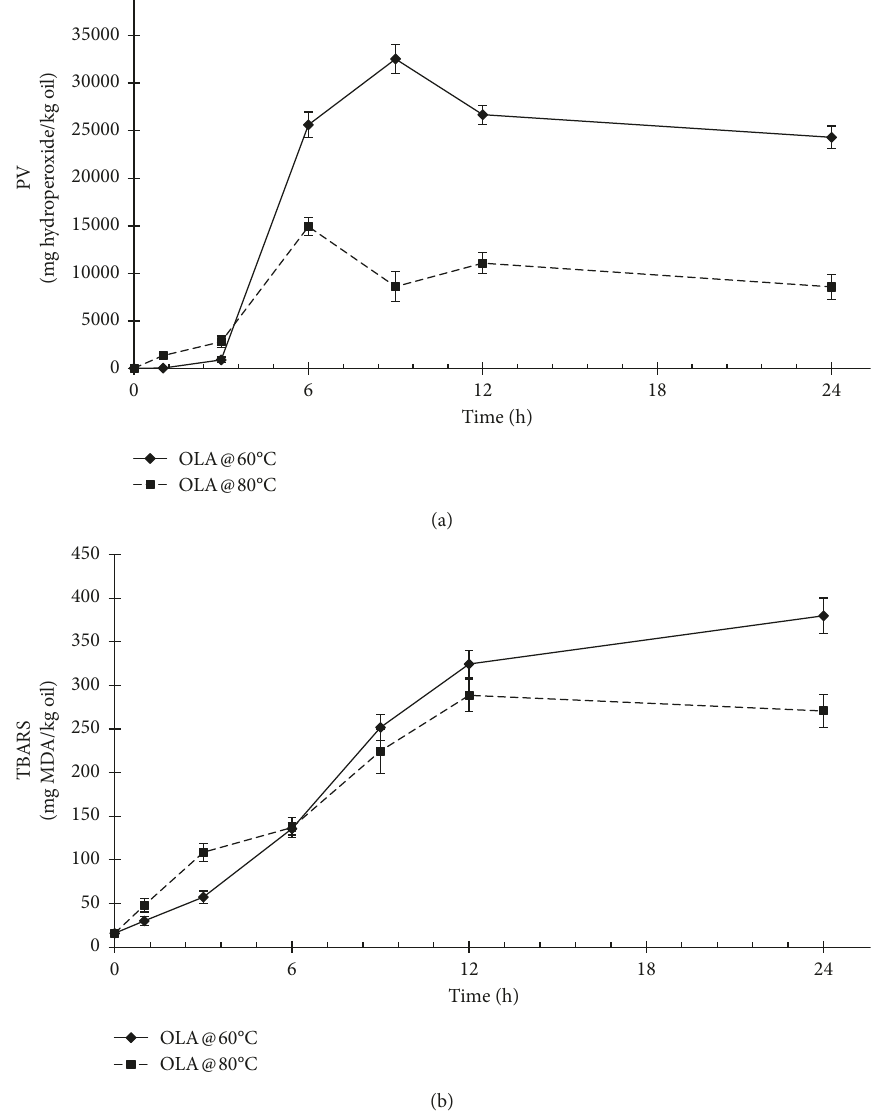
Figure 1: Changes in peroxide value (a) and TBARS value (b) of OLA prepared at different temperatures for various times. The bar represents the standard deviation ( n (cid:30)